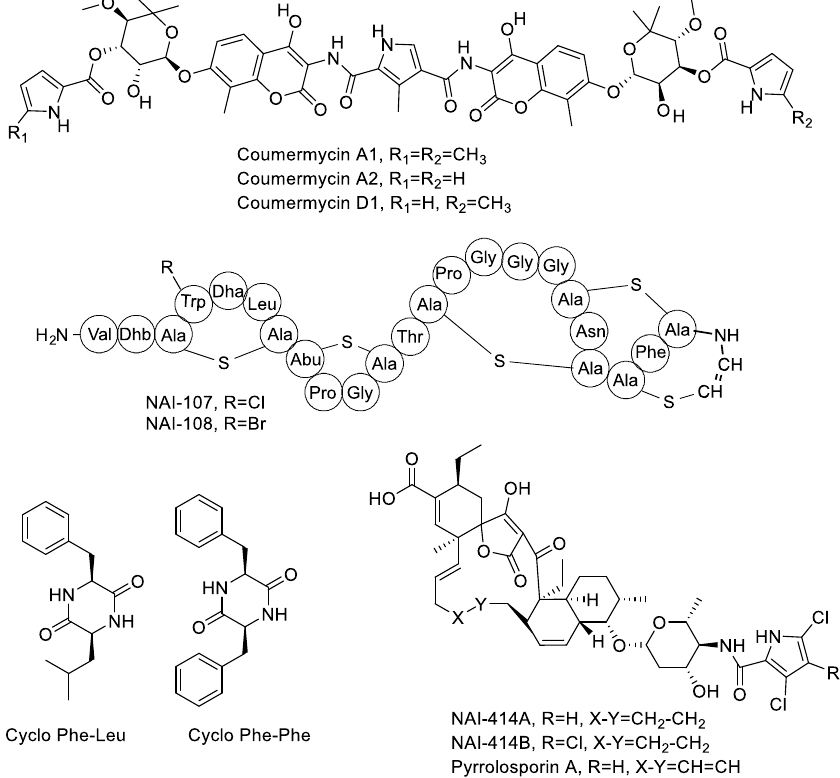
Figure 1. Chemical structures of molecules produced by Actinoallomurus and described in Section